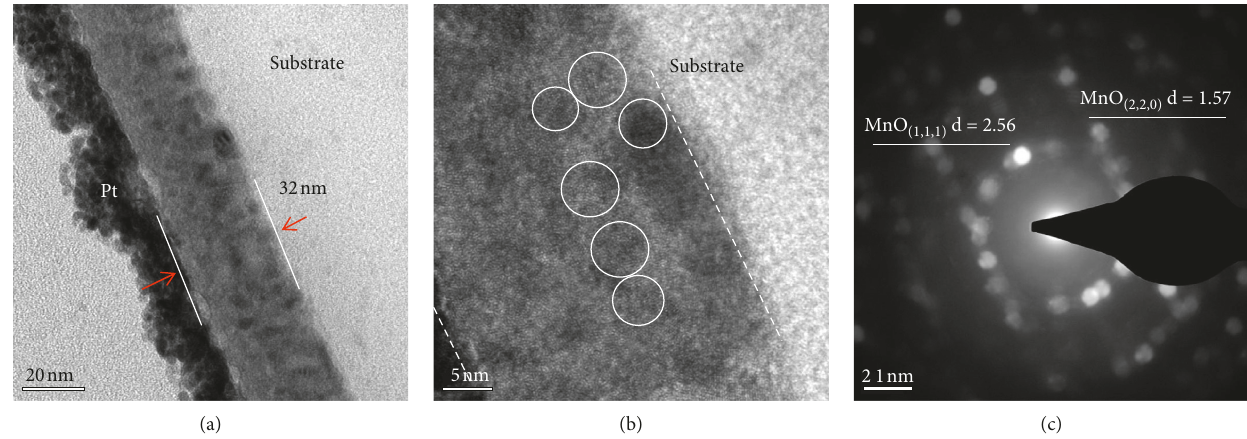
Figure 5: CuMn film TEM micrographs with 19.6 at.% Y addition annealed at 350 ° C: (a) cross-section bright field, (b) selected-area electron diffraction, (c) SAD analysis, and (d) HRTEM